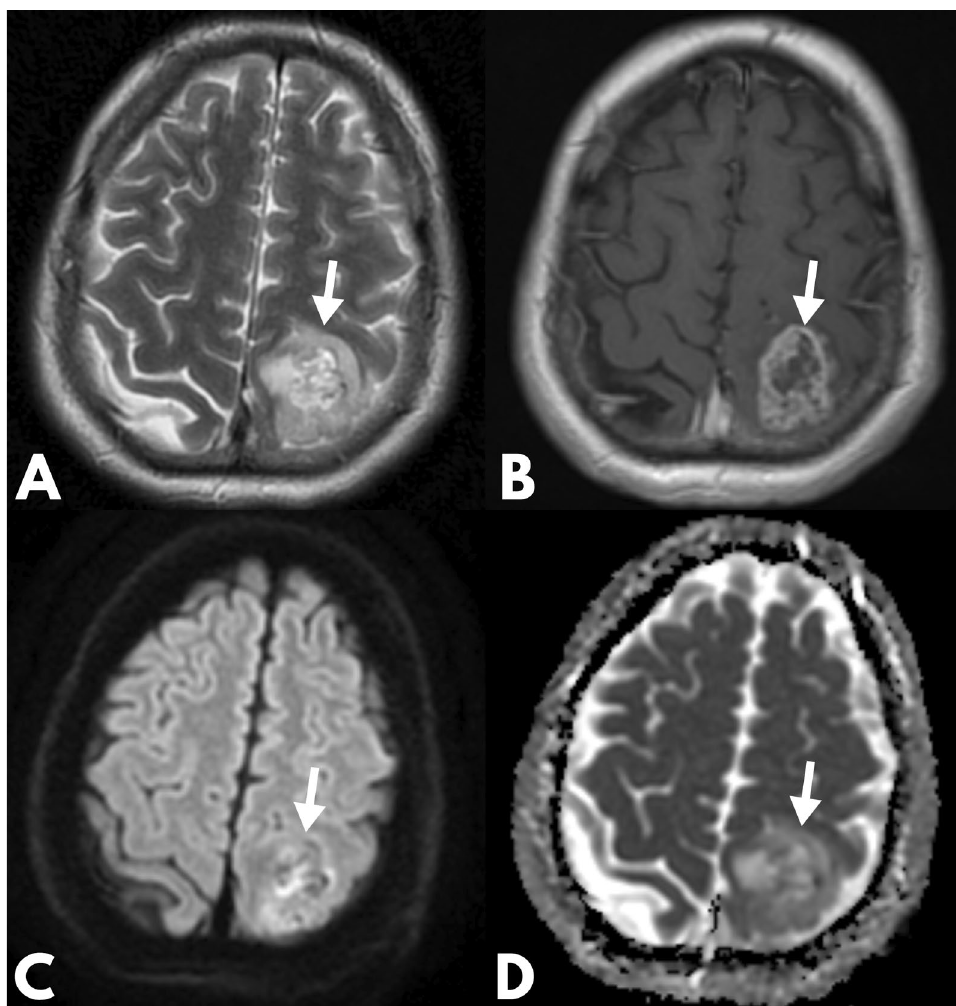
Fig. 2 IDH-mutant glial tumour in the left cerebral hemisphere. A: Axial T2W magnetic resonance image demonstrates a lobulated mass with the heterogeneous signal. B: Axial contrast material-enhanced T1-weighted image shows irregular ring enhancement. C and D : DWI ( C ) sequence and ADC ( D ) show areas of diffusion restriction in the central and peripheral parts of the